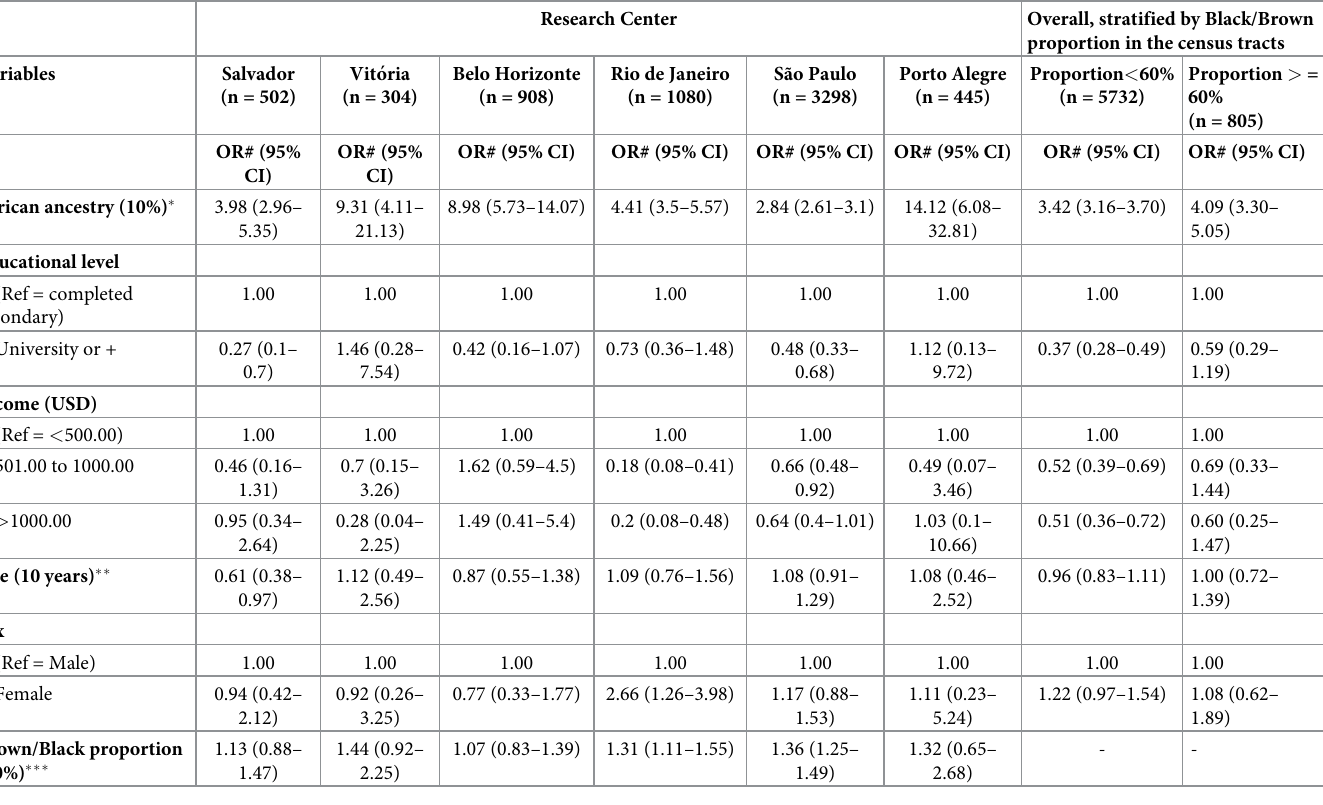
Table 2. Odds ratios of self-declaring as black (compared to white) according to research centre and total. ELSA-Brasil,